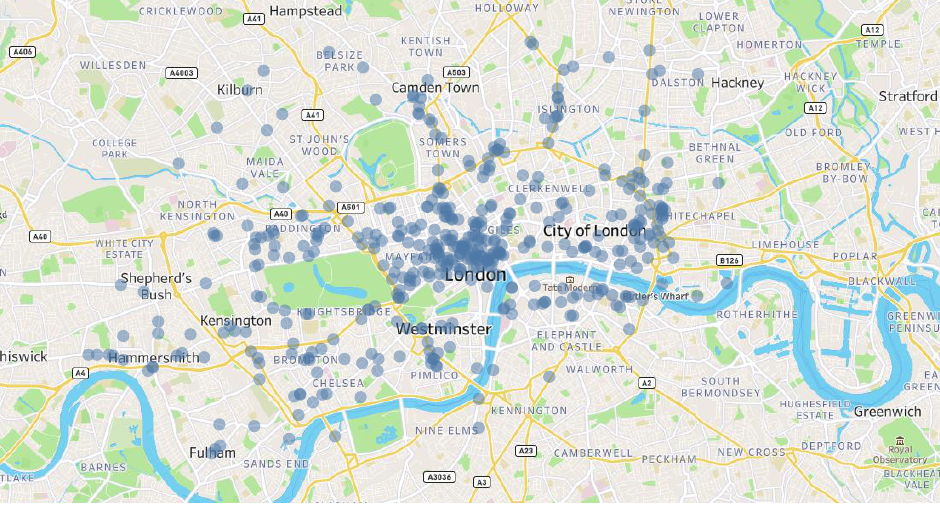
Figure 5. The locations of the restaurants on the map.